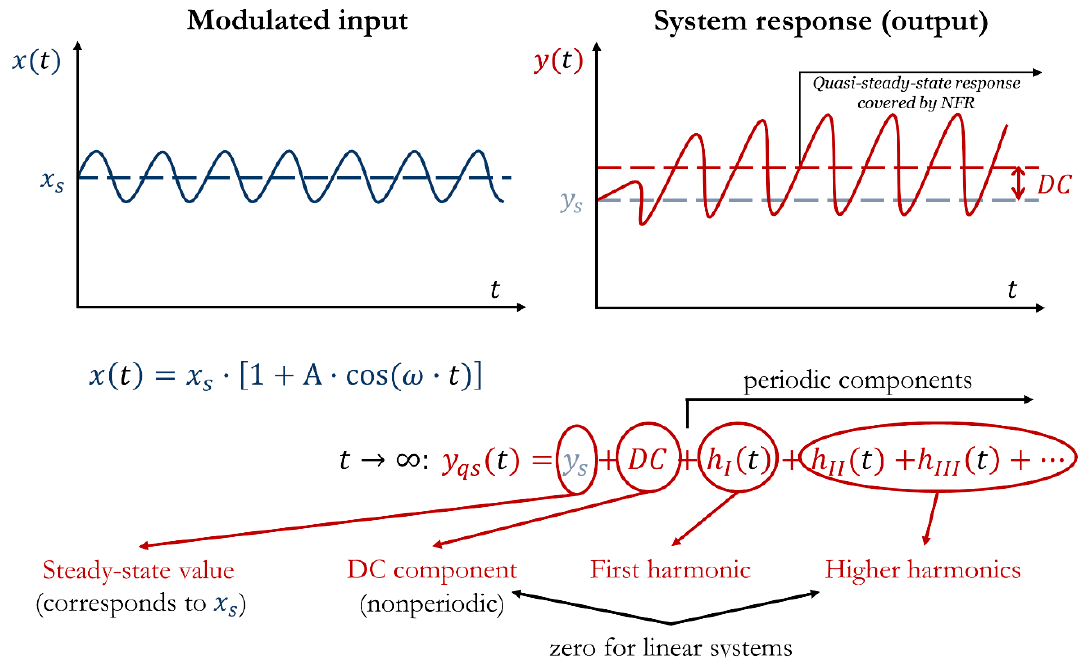
Figure 1. Response of a weakly nonlinear system, y ( t ) , to a periodically modulated input, x ( t ) , around its steady-state value x s with an amplitude A and frequency ω